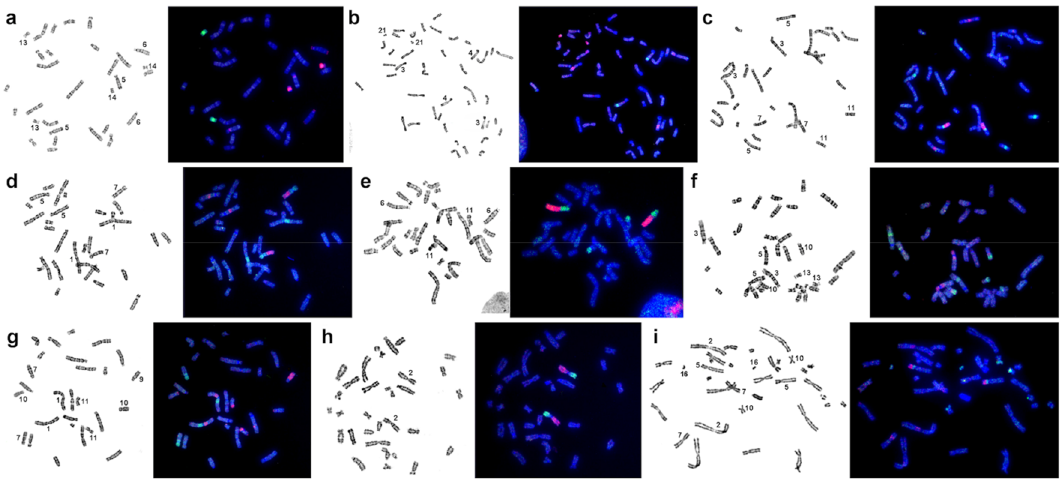
Figure 3. Examples of FISH data. Localization of U. kamensis microdissection-derived probes: ( a ), U1 (green) and U2 (red) on chromosomes of U. kamensis ; ( b ) U3 (green) and U4 (red) on chromosomes of M. auratus . Localization of M. auratus chromosome–specific probes on chromosomes of U. kamensis : ( c ) 14 (green) and 16 (red); ( d ) 9 (green) and 16 (red); ( e ) 4 (green) and 10 (red); ( f ) 3 (green) and 11 (red); ( g ) 9 (green) and 5 (red); and ( h ), 18 (green) and 7 (red). ( i ) Localization of microdissection-derived probes of M. auratus 16 (red) and M11 (green) on chromosomes of P. roborovskii . G-banded metaphases are presented on the left.